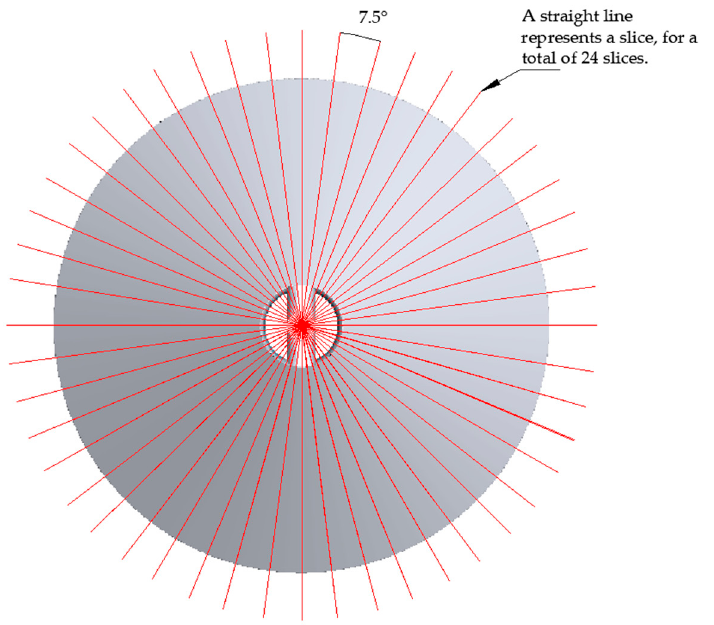
Figure 6. Distribution of 24 slices with an interval of 7.5 degrees for postprocessing .